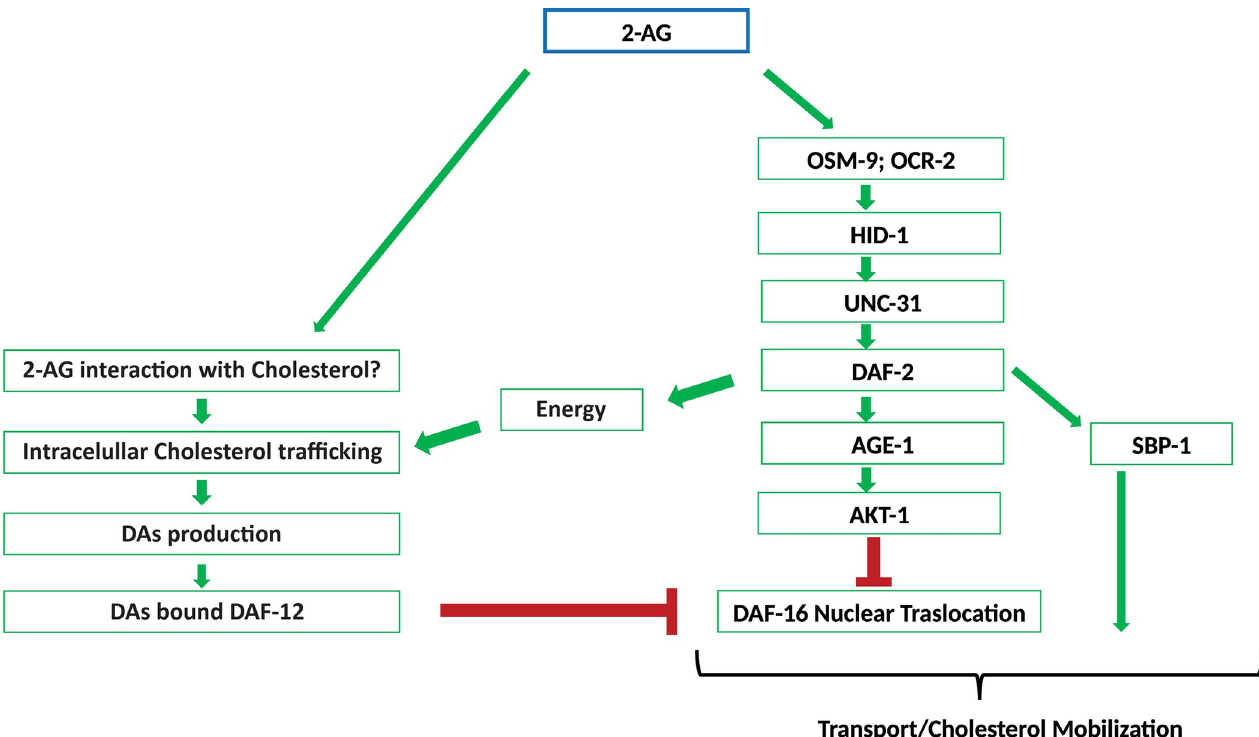
Fig 8. Working model of 2-AG dependent mobilization of cholesterol. Under interaction of 2-AG with an unknown target in sensory neurons, multiple signaling mechanisms are likely to converge on activation of the IIS pathway and inhibition of DAF-16/FOXO. Signaling through the DAF-2 insulin receptor has several functions and could be involved in modulation of the intracellular traffic of cholesterol. The interaction of SBP-1 with the IIS pathway remains to be established, but is likely that such interaction is essential for 2-AG-dependent mobilization of cholesterol. For more details see the text.